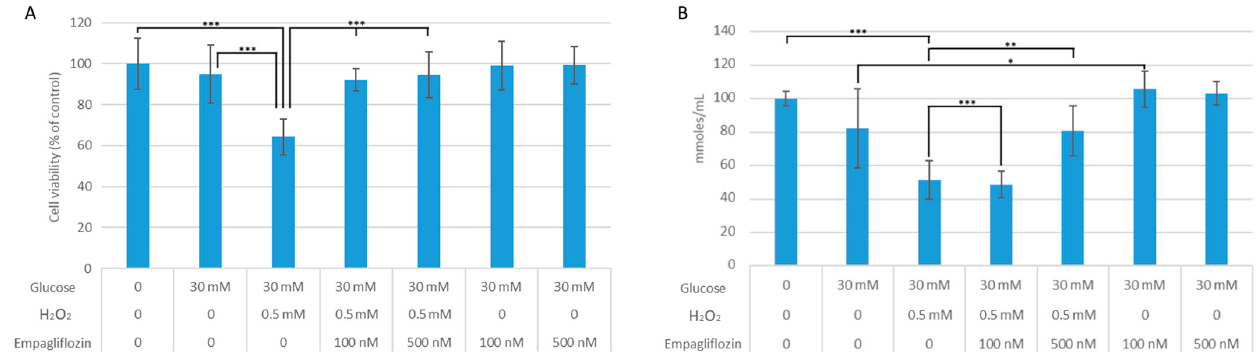
Figure 1. ( A ) Effects of empagliflozin on cell viability in LLC-PK1 cell line. One-way ANOVA F(6,58) = 11.59, p = 3.41 × 10 − 8 , and Tukey HSD post hoc test. ( B ) Influence of empagliflozin on GSH levels in LLC-PK1 cell line. One-way ANOVA F(6,47) = 24.5, p = 4.21 × 10 − 12 , and Tukey HSD post hoc test. Values are expressed in micromoles per millilitre as the mean with standard deviation ± SD. Values below the x -axis indicate the quantity of compounds. * p < 0.05; ** p < 0.01; *** p < 0.001.